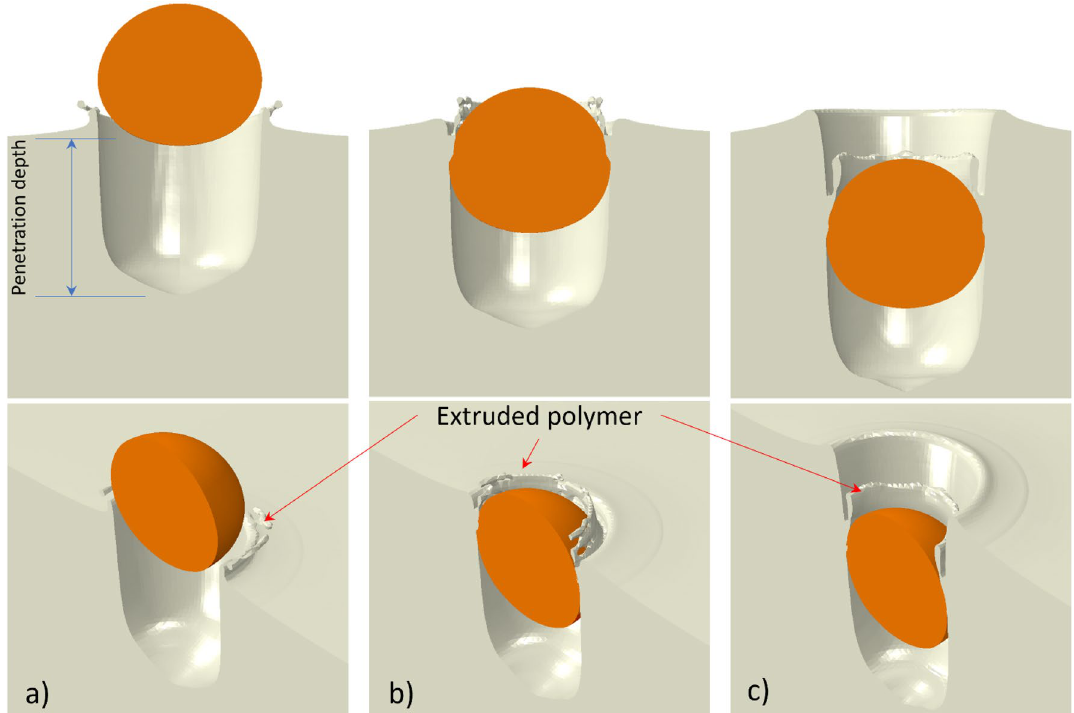
Figure 6. Front and isometric views of the final configuration (with an analysis duration of 5 × 10 − 7 s ) for particle and deformed substrate using the original material model impacting at V p = 500m / s , T p = 100 ◦ C : ( a ) T s = 25 ◦ C , ( b ) gradient T s with T u